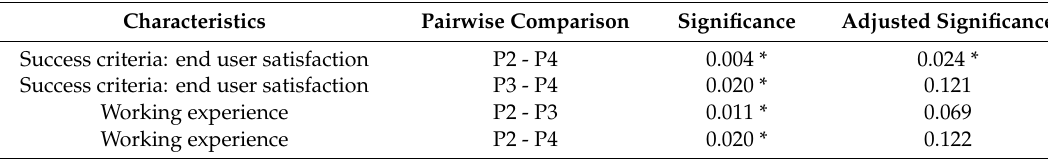
Table 2. Significant results from the pairwise